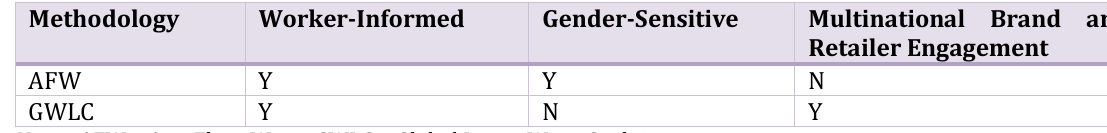
Table 1. Summary of living wage methodology